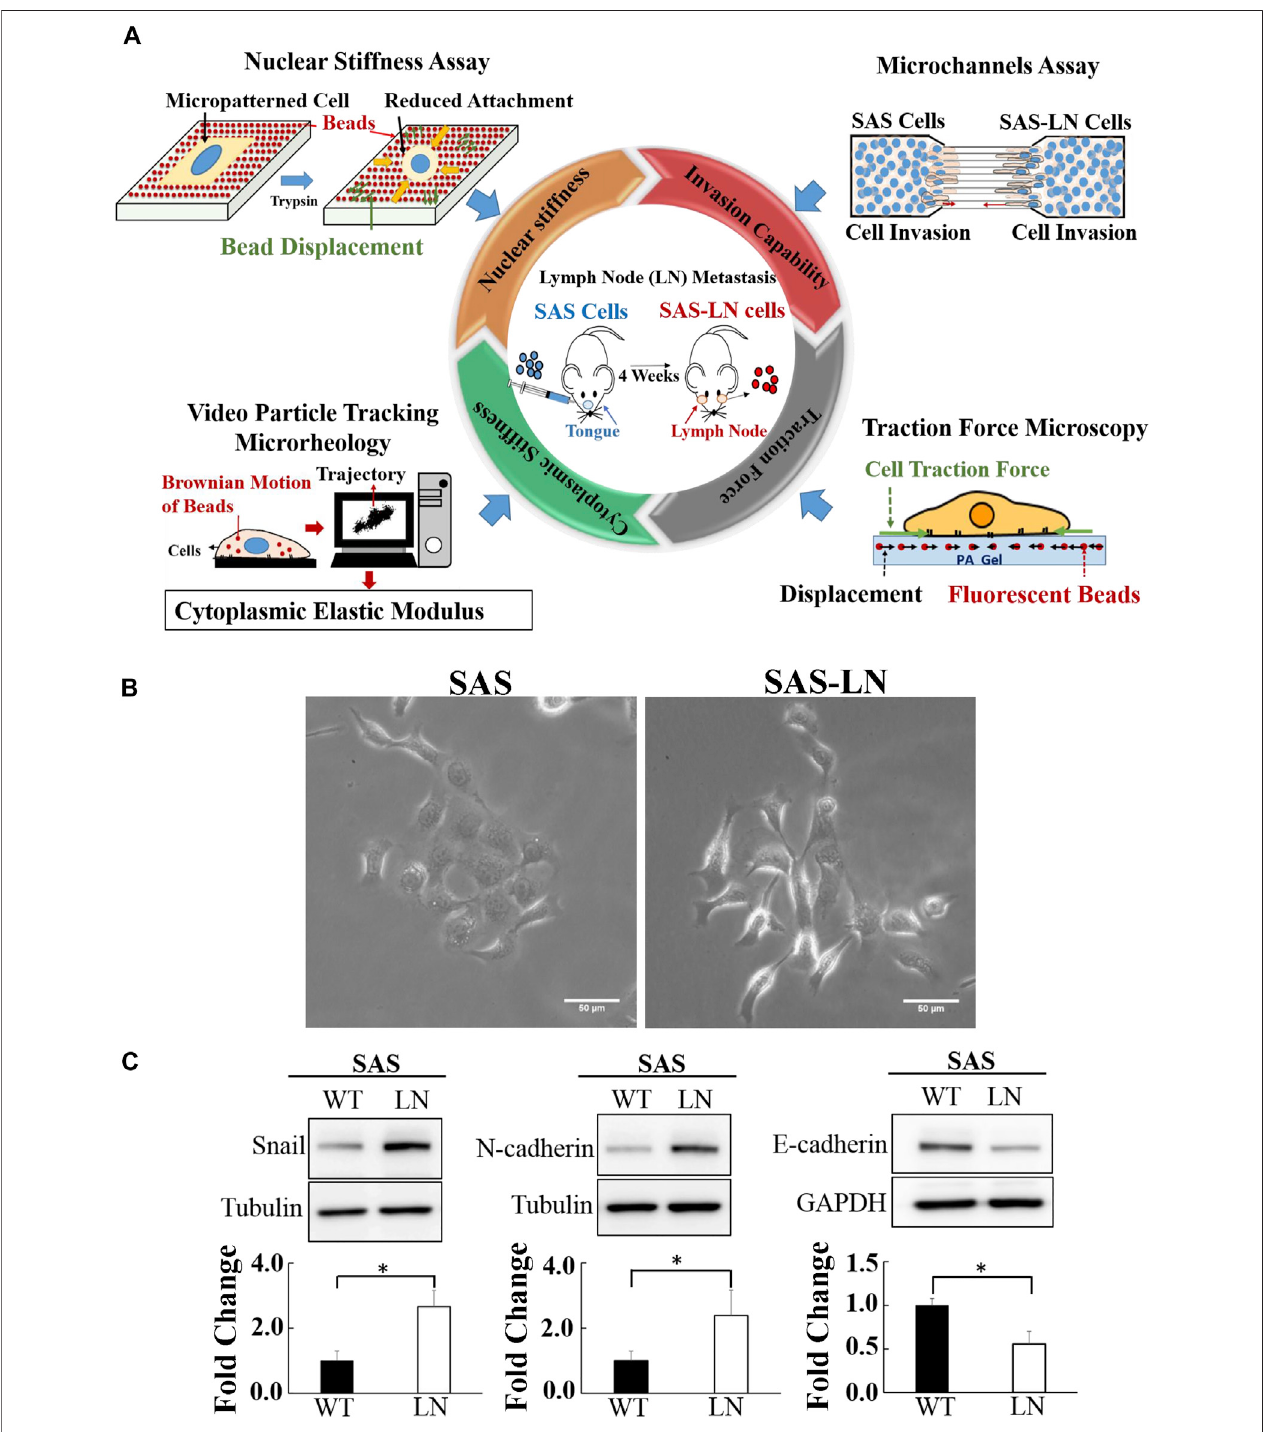
FIGURE 1 | Characterization of the biomechanical properties and the expression of epithelial – mesenchymal transition marker proteins of lymph node (LN)- metastatic and non-metastatic head and neck squamous cell carcinoma (HNSCC) cells (SAS-LN and SAS cells). (A) A schematic diagram of multiple biophotonics platformstoquantifythebiomechanicalpropertiesofSAS-LNand SAScells, includingnuclearstiffnessvianuclearstiffnessassay;invasioncapability viaamicrochannel assay with different channel widths (12, 16, and 20 μ m); cytoplasmic stiffness via video particle tracking microrheology; and cell traction force via traction force microscopy. (B) Phase contrast images of LN-metastatic and non-metastatic HNSCC cells (SAS-LN and SAS cells). Scale bar = 50 μ m. (C) Western blot of Snail, N-cadherin,andE-cadherininSAS-LNandSAScellsandfoldchangeexpressionrelativetoSAScells.TubulinandGAPDHwereusedasloadingcontrol.Datarepresent mean ± SD (n = 3). *, for p < 0.05 and **, for p < 0.01.